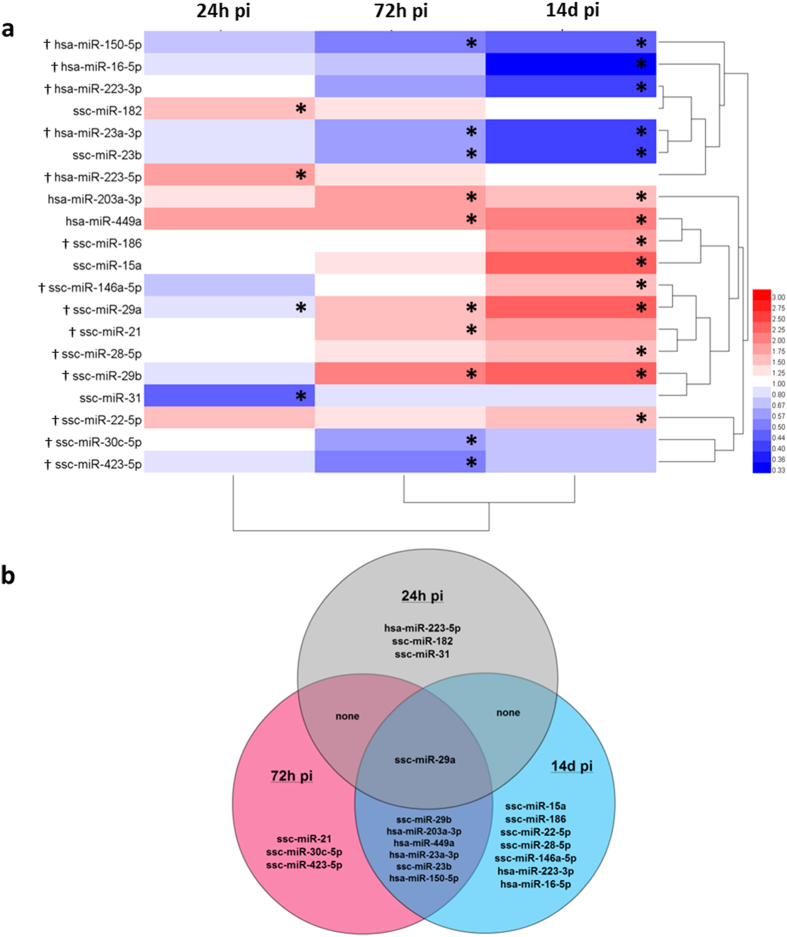
Expression of miRNA in porcine leukocytes after IAV challenge.(a) clustered heat map depicting up- and down-regulation (red and blue, respectively) at 24 h, 72 h, and 14d pi compared to before challenge. *Indicates statistical significance at that time point. †Indicates that the miRNA have previously been reported to be regulated in circulation in human patients after IAV infection111213. Human (hsa-) miRNAs: hsa-miR-223-3p, hsa-miR-223-5p, hsa-miR-203a-3p, and hsa-miR-449a are not yet annotated in the porcine genome. hsa-miR-150-5p, hsa-miR-16-5p, and hsa-miR-23a-3p were not annotated in the pig genome at the time the assay was designed, but sequences have since become available and found to be 100% identical to the human homologs that were used for primer design. (b) Venn diagram showing at which post challenge time points miRNAs were regulated compared to before challenge.